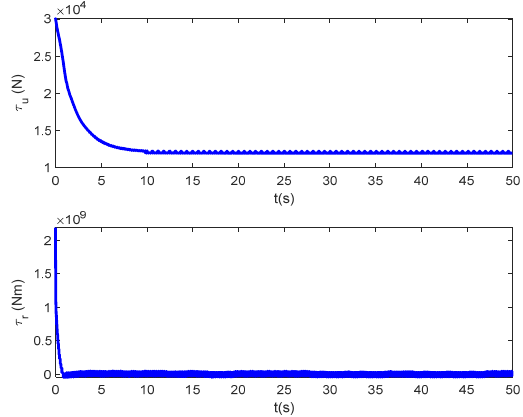
Figure 3. The yaw moment and surge force.